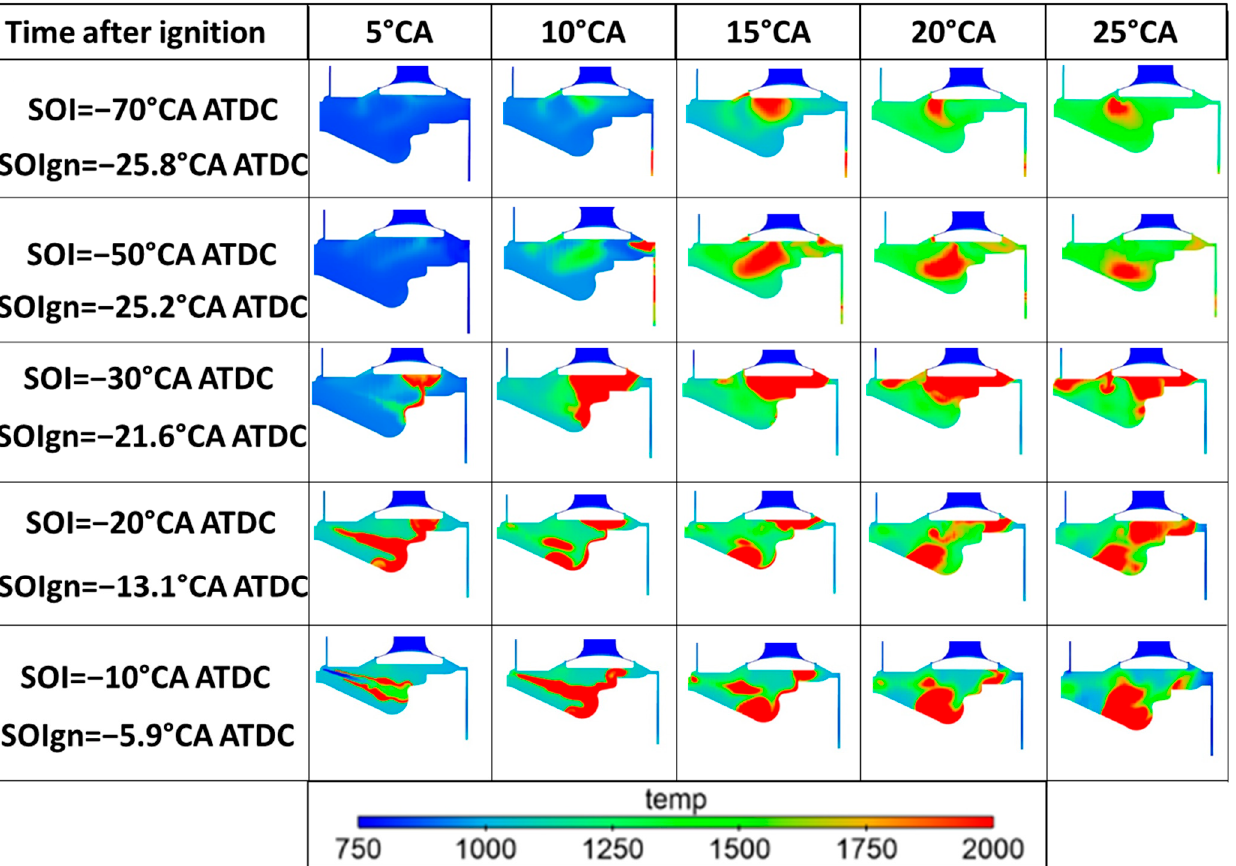
Figure 20. Time histories of temperature contour plot in a plane formed by the cylinder axis and a spray axis according to °CA after SOIgn for various SOI timings.